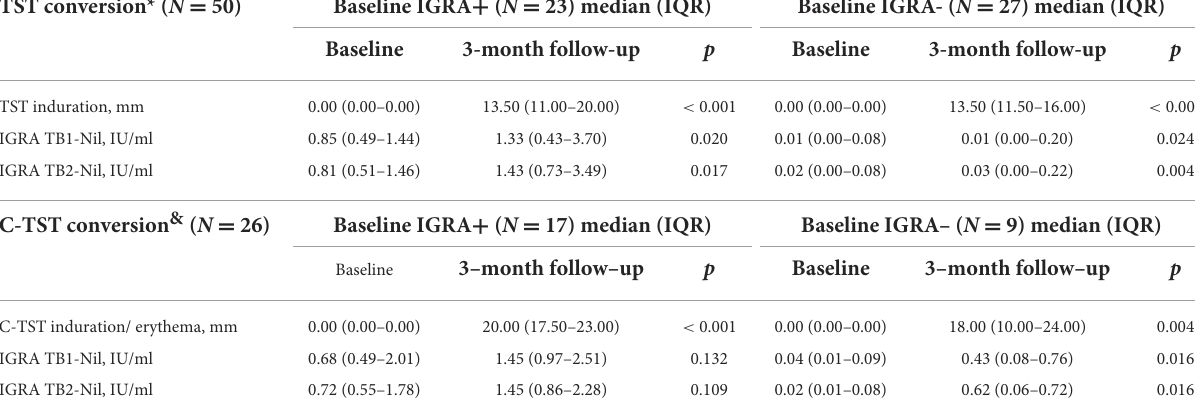
TABLE 5 Quantitative results of TST, C-TST and IGRA in skin testing converted